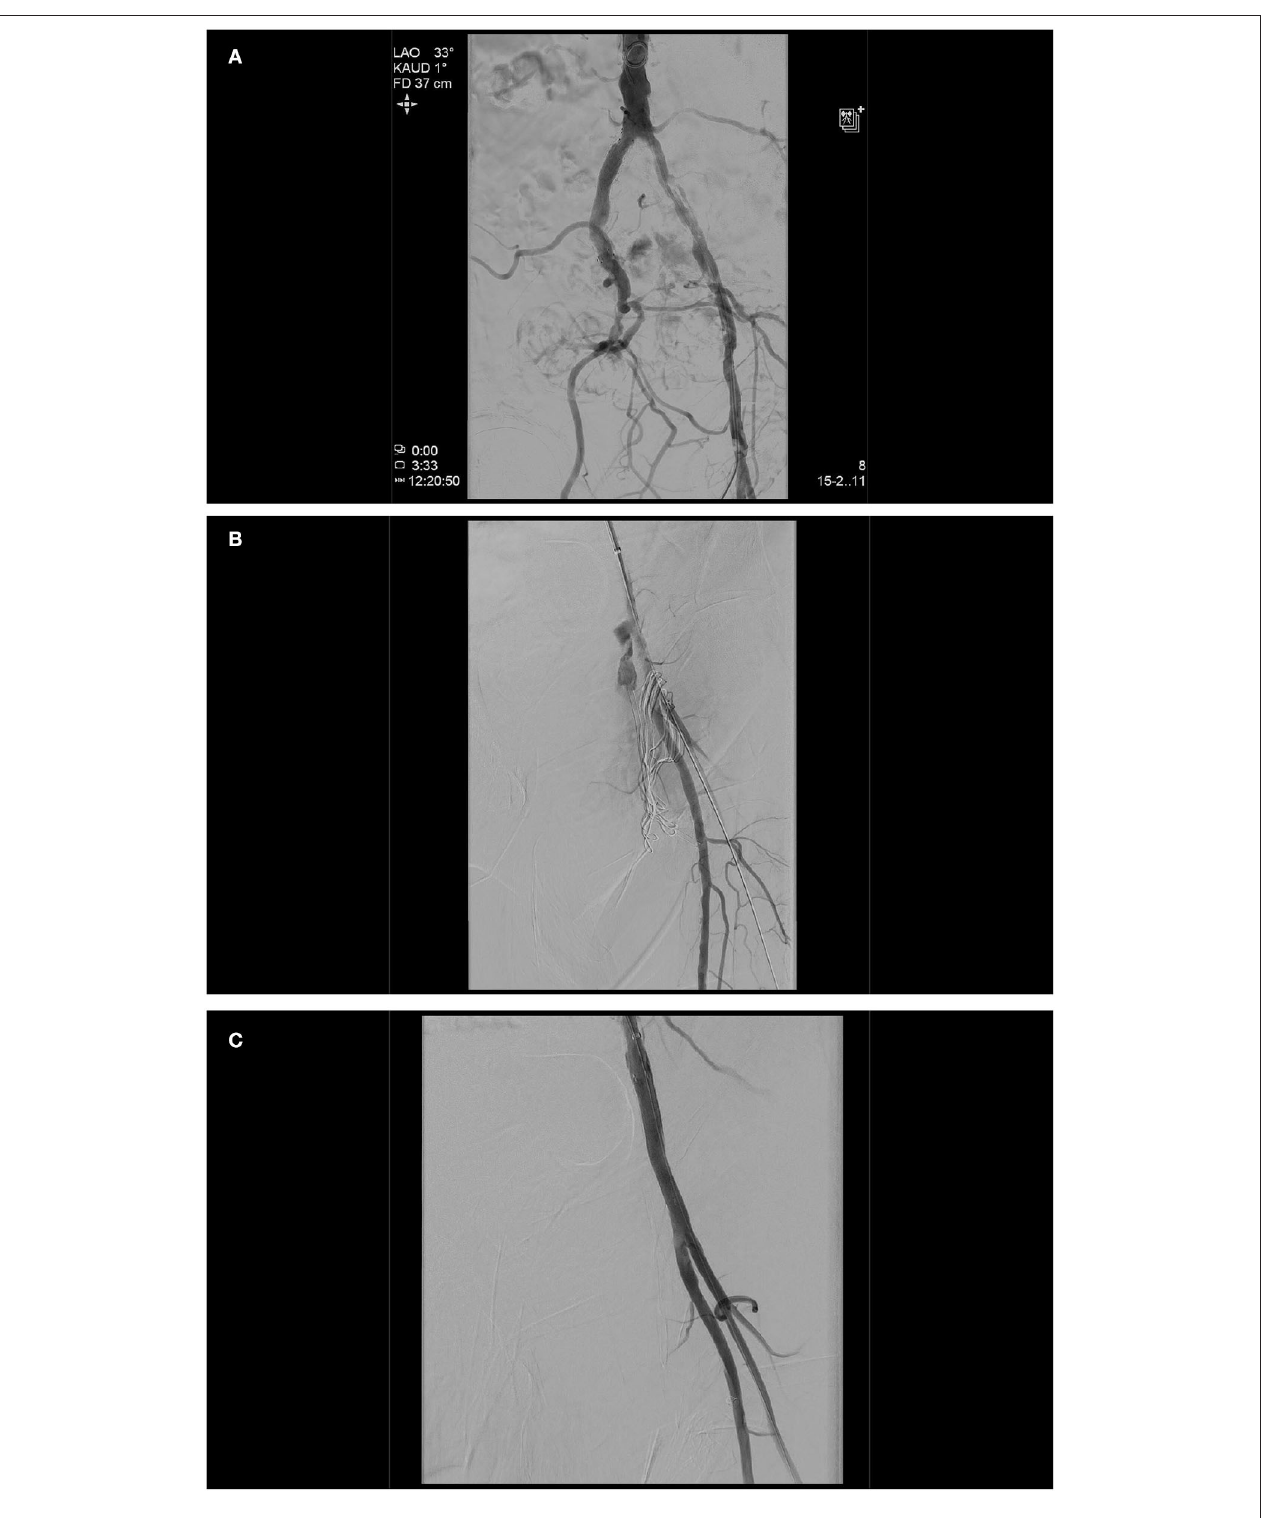
FIGURE 1 | Initial angiogram demonstrating severely calcified left iliac arteries and a chronic occlusion of the right external iliac artery (A) . As a second arterial access, the left brachial artery was chosen, based on the fact that only one brain-supplying artery (left vertebral artery) would be crossed in the process, the shorter and more direct route to the peripheral arteries in the event of an access site or a problem even further downstream. A transcatheter aortic valve implantation (TAVI) procedure